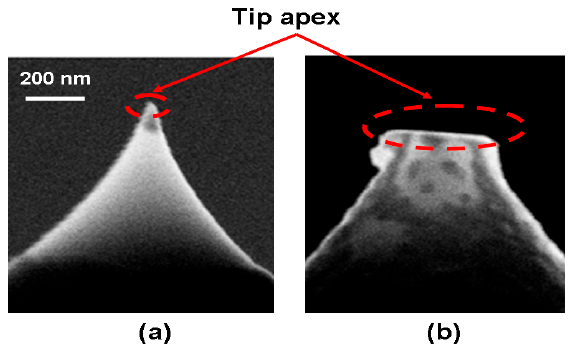
Figure 5. SEM images of a Si tip ( a ) without wear and ( b ) with wear.